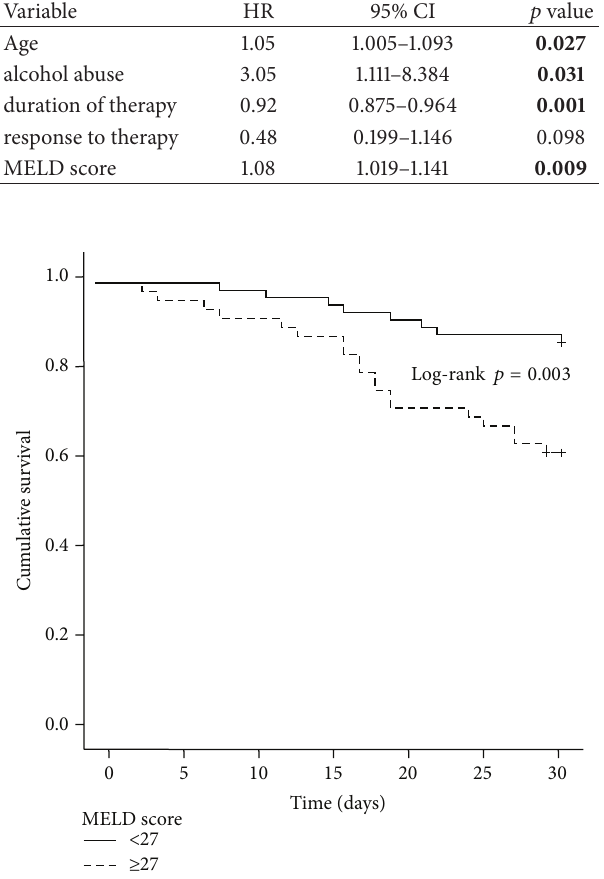
Figure 5: Kaplan-Meier survival analysis of the patient cohort: mean short-term survival was significantly longer in patients with MELD score less than 27 compared with those having a MELD score > 27: 28.5 days [95% CI 27.3–29.7] versus 25.4 days [95% CI 23.4– 27.5] (MELD score < 27 versus MELD score ≥ 27, log-rank test, 𝑝 = 0.003